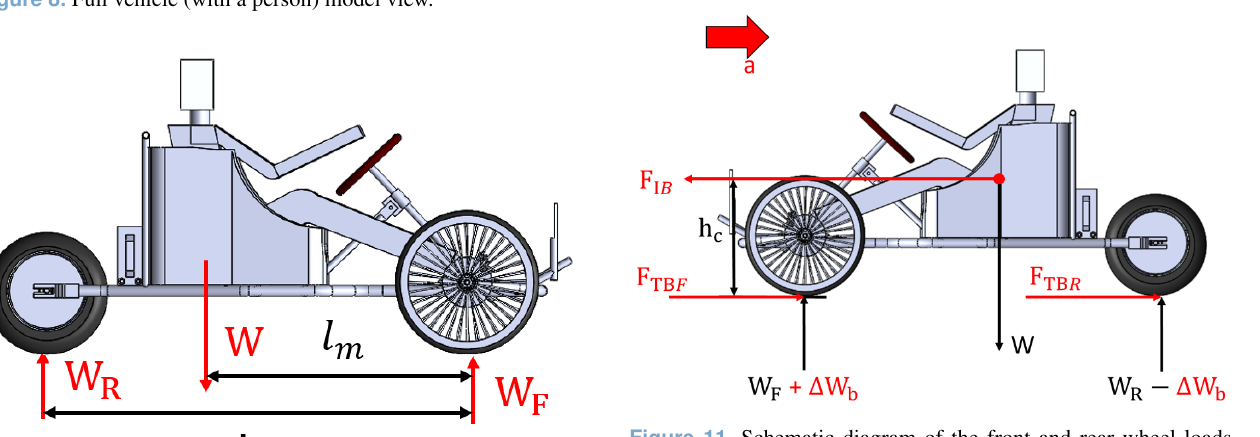
Figure 11. Schematic diagram of the front and rear wheel loads (braking).